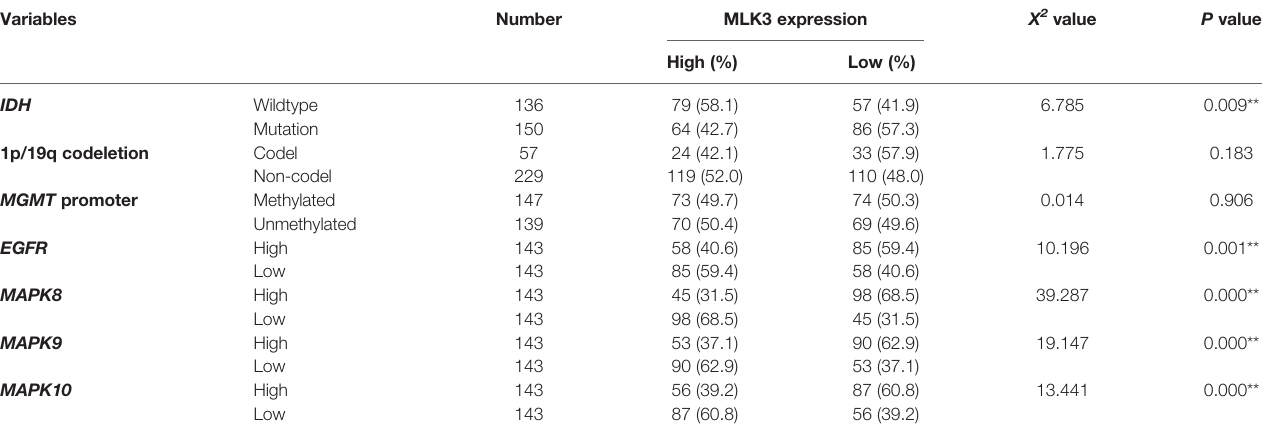
TABLE 2 | Relationship between MLK3 mRNA expression and clinicopathologic variables of patients with gliomas.